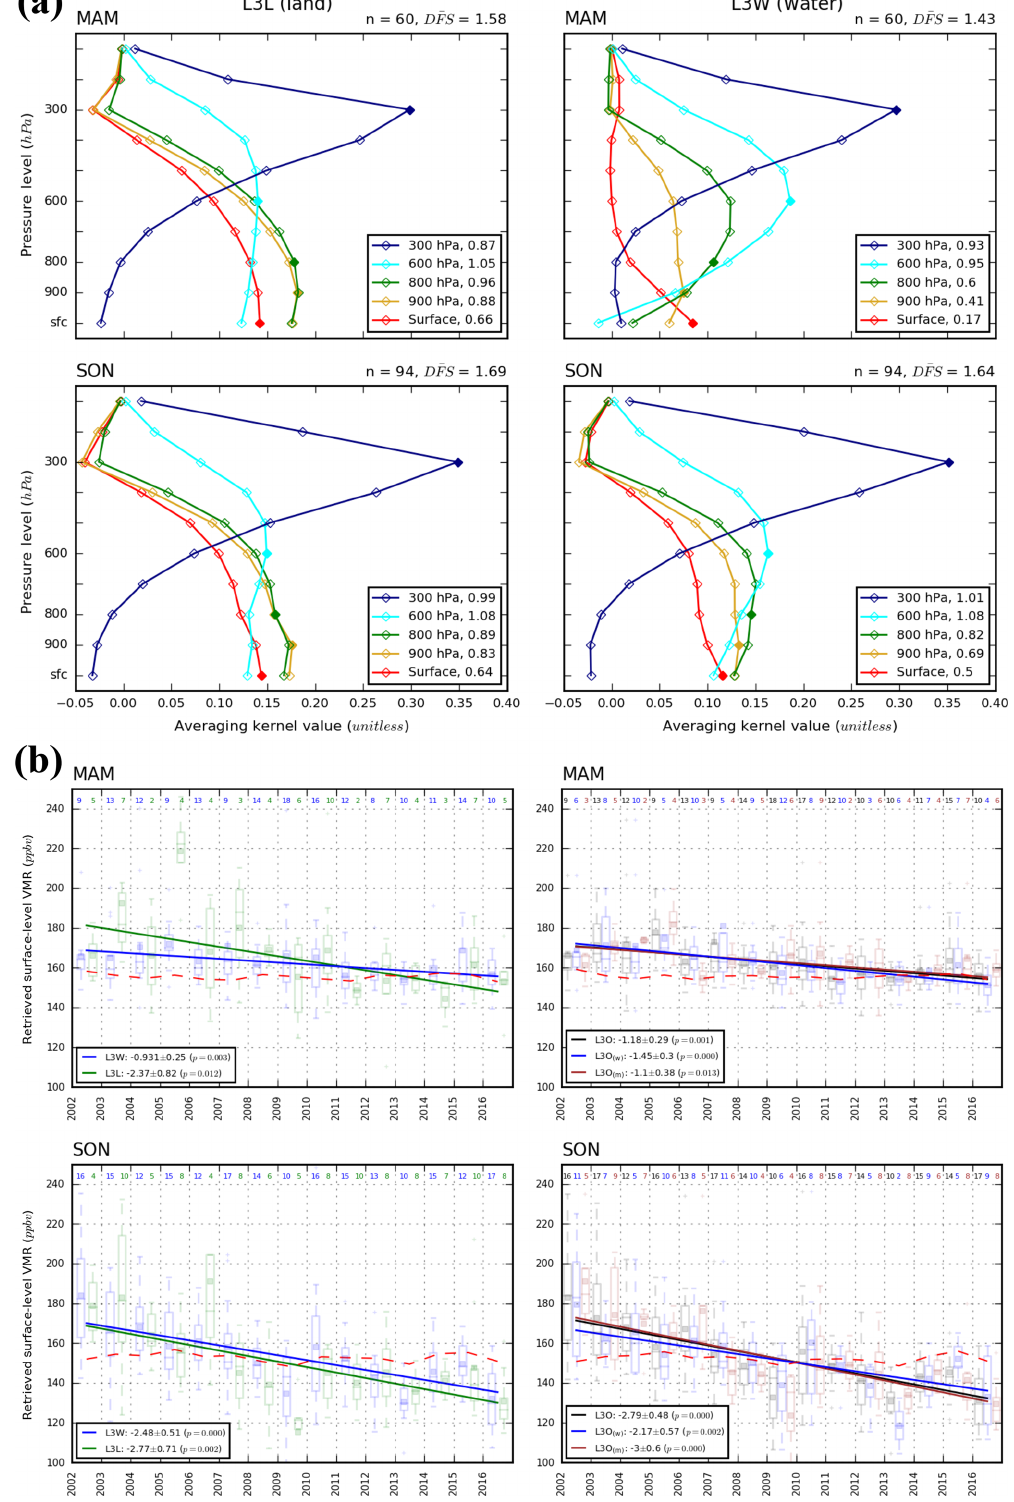
Figure 10. (a) As Fig. 3 but for MAM and SON; (b) as Fig. 9 but for MAM and